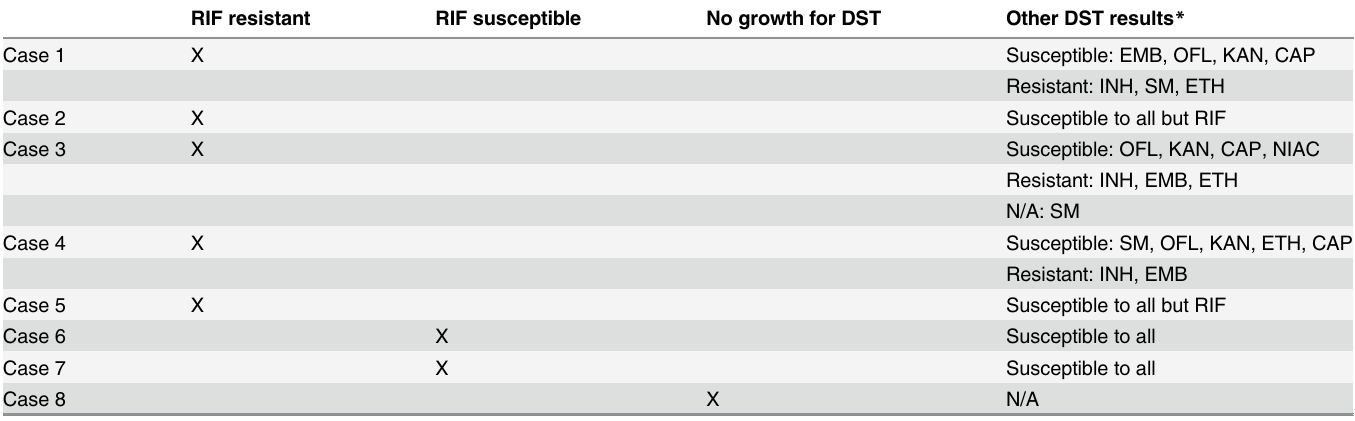
Table 4. MGIT liquid culture drug-susceptibility testing (DST) results for patients identified as RIF-R by GeneXpert. (Bold font denotes MDR). RIF